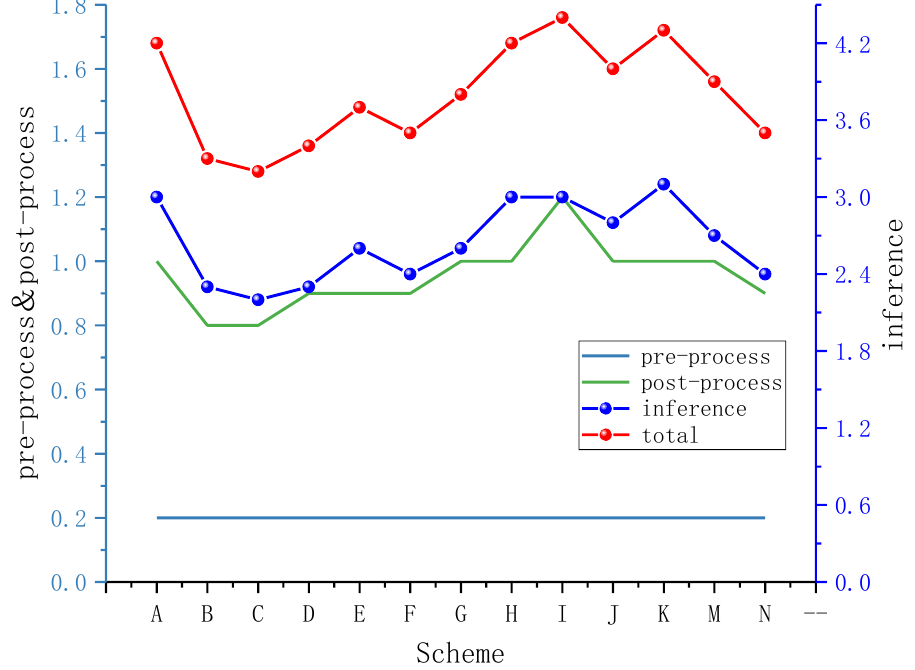
Figure 8. The detection time curves under different schemes. “A–N” represents the different schemes presented in Table 6.